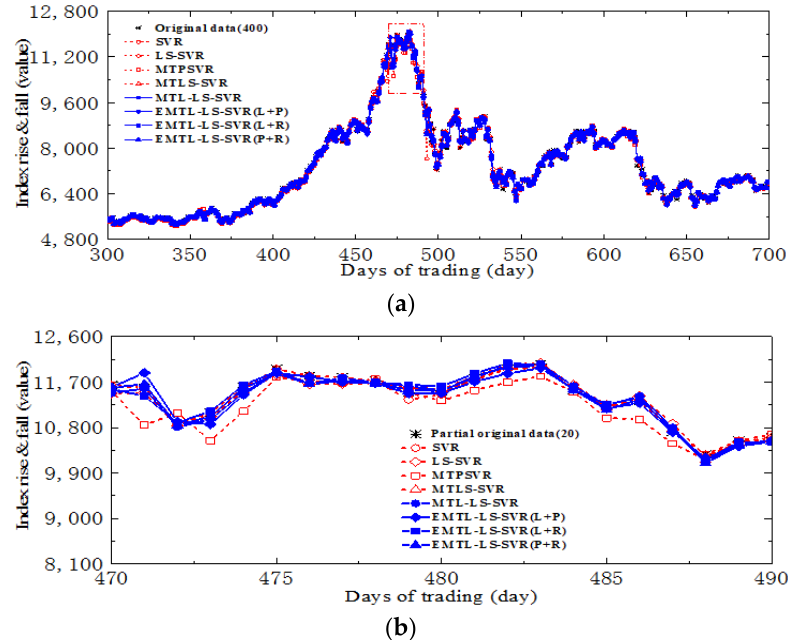
Figure 7. Predictions of different regression models on opening index for SZSMEPI ( a ) Original figure, ( b ) Enlarged figure.